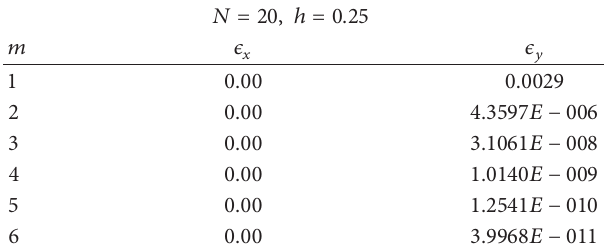
Table 1: Numerical results for